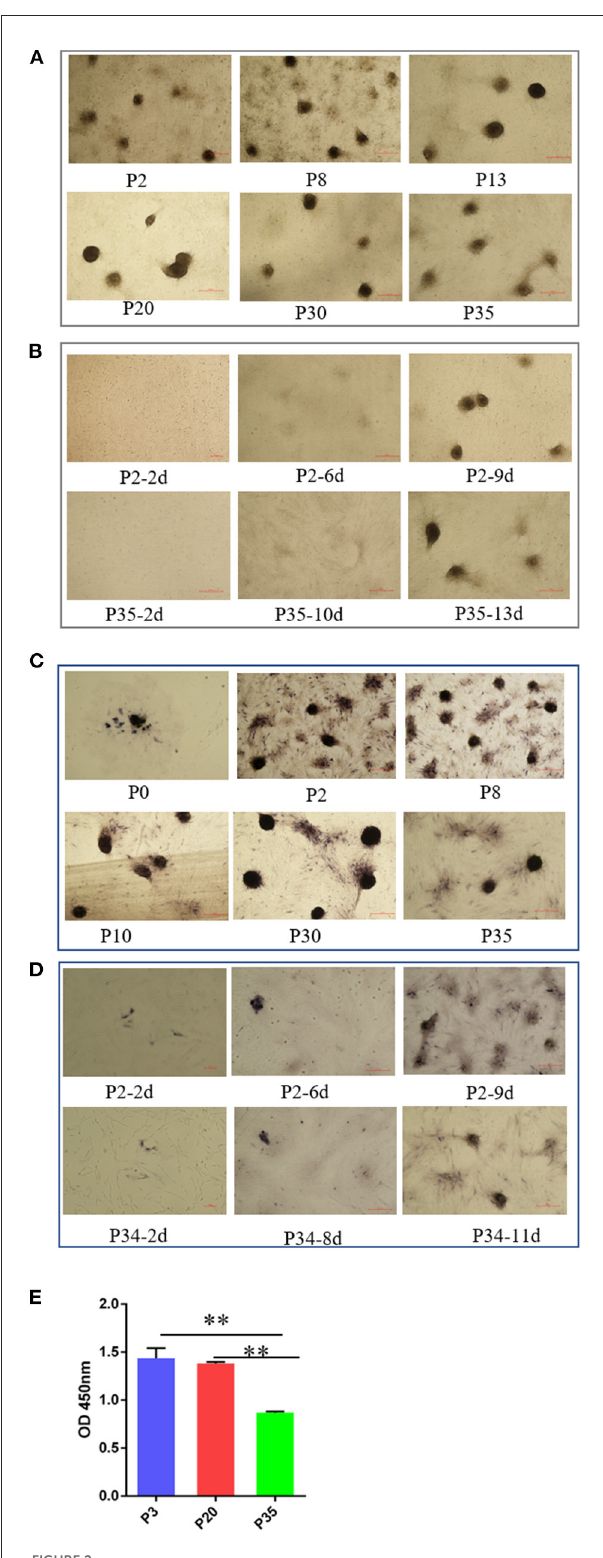
FIGURE2 The change of intrinsic properties of DPCs during a period of culture ex vivo . (A) The ability of cell aggregation from early passaged ovine DPCs to multiple passaged DPCs. The agglutinated cells will eventually form three-dimensional spheroids projecting up from the culture substrate (B) . The difference of cell aggregation ability between early passaged ovine DPCs to multiple passaged